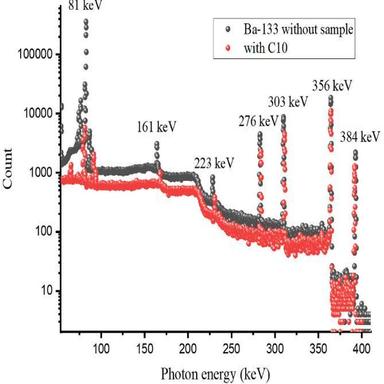
Absorption spectra obtained for C10 glass using 133Ba radioactive source.